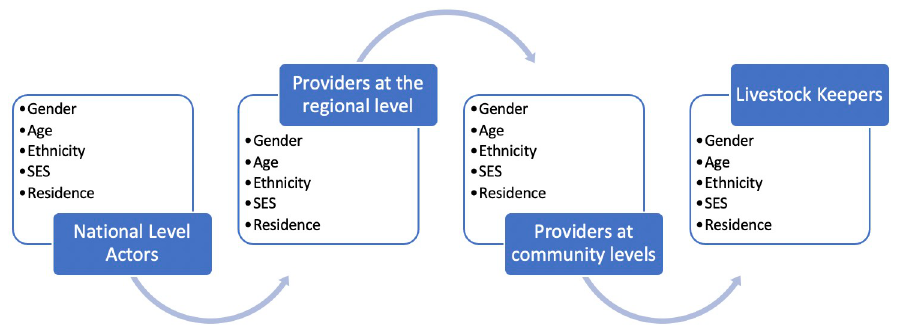
Fig 1. GITA approach to livestock vaccine value